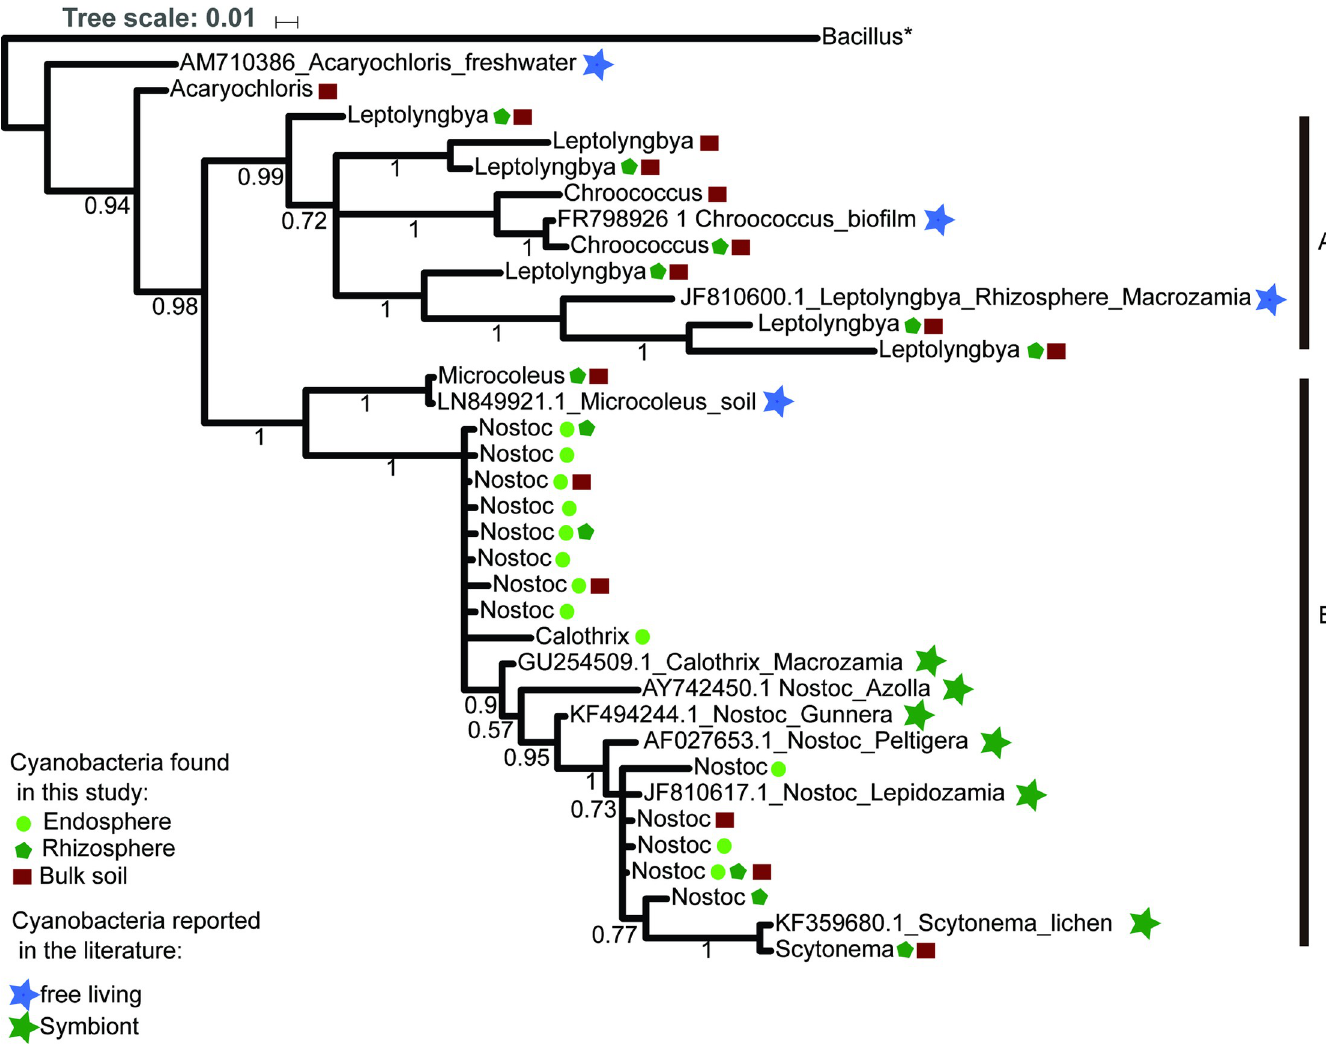
Fig 6. Phylogeny of the genera belong to cyanobacteria found in the three compartments (set “Bulk soil” comparison). The ingroup contains 7 cyanobacteria genera and 25 OTUs. The endosphere, rhizosphere, and bulk soil are represented by a circle (yellow), Pentagon (Maroon), and square (Green) respectively. The cyanobacteria reported in the literature are represented by a star, the color blue indicates free-living cyanobacteria and green indicates those that live in symbiosis. The letters: A and B denote the main clades formed in the analysis. The values above branches are the posterior probabilities.